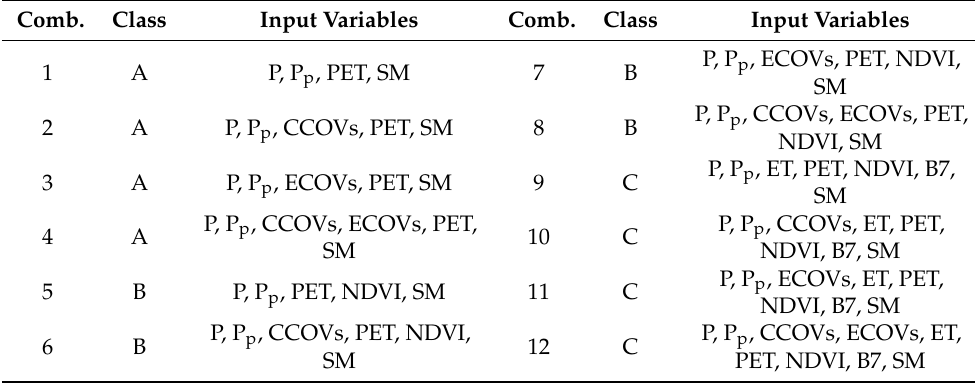
Table 4. Combinations (Comb.) of input variables (P: precipitation; P p : precipitation